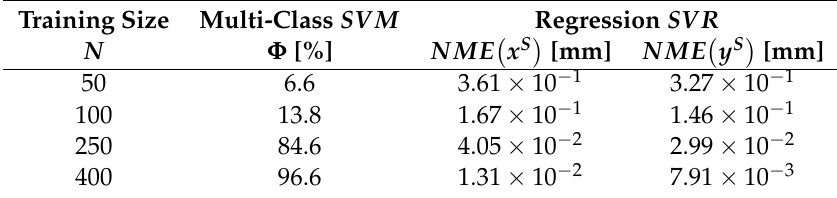
Table 2. Experimental Assessment. ( V = 8, f 0 = 900 MHz, (cid:101) ε B = 41.8 ε 0 − j 0.97 S = 48.63 ε − j 1.28 , M = 500, P = 25)—Error indexes vs. training size when solving Step 3 (cid:101) ε 0 H 2 π f 0 (“Localization”) through multi-class SVM and SVR